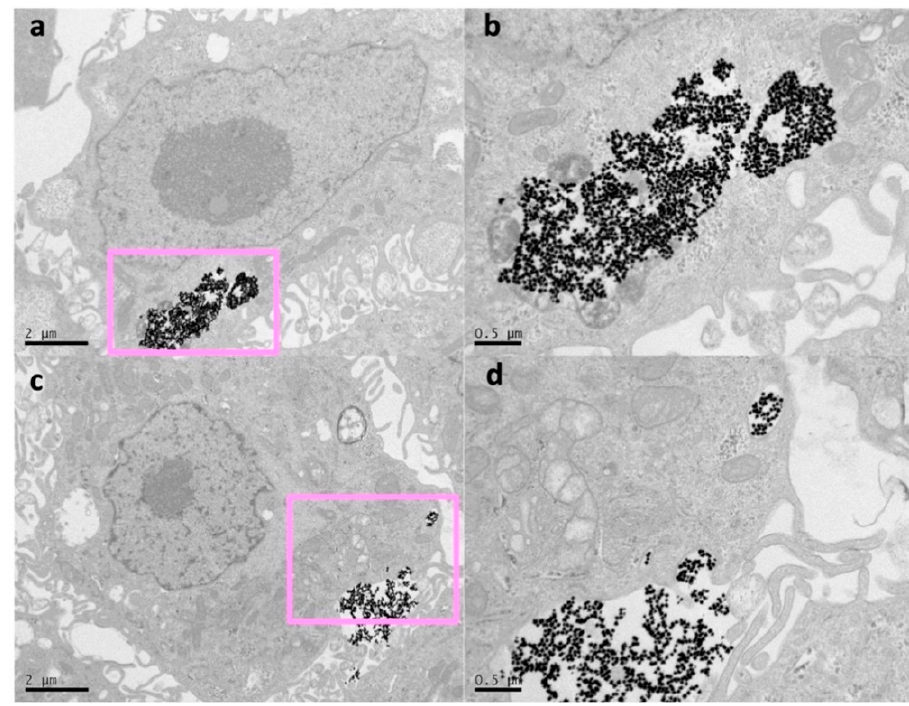
Figure 3. ( a ) TEM micrograph of a single cell loaded with Au NSs and ( b ) image at higher magnification after incubation with 8 pM Au NSs. ( c ) Micrograph after 48 h of incubation and ( d ) image at higher magnification, in which many regions can be seen where the Au NSs have been exocyted and locate between two cells, as well as small vesicular compartments with smaller amounts of Au NS.